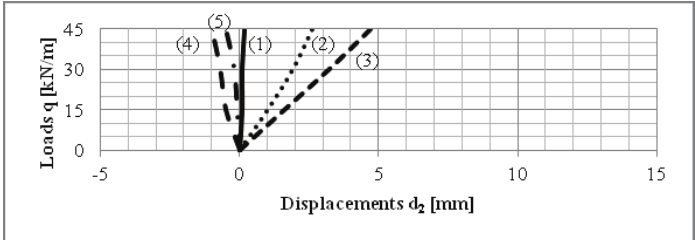
Fig. 6c. Displacements d 2 (mm) depending on the use of sheet piles as a cover of the foundation. Horizontal load applied at the bearing